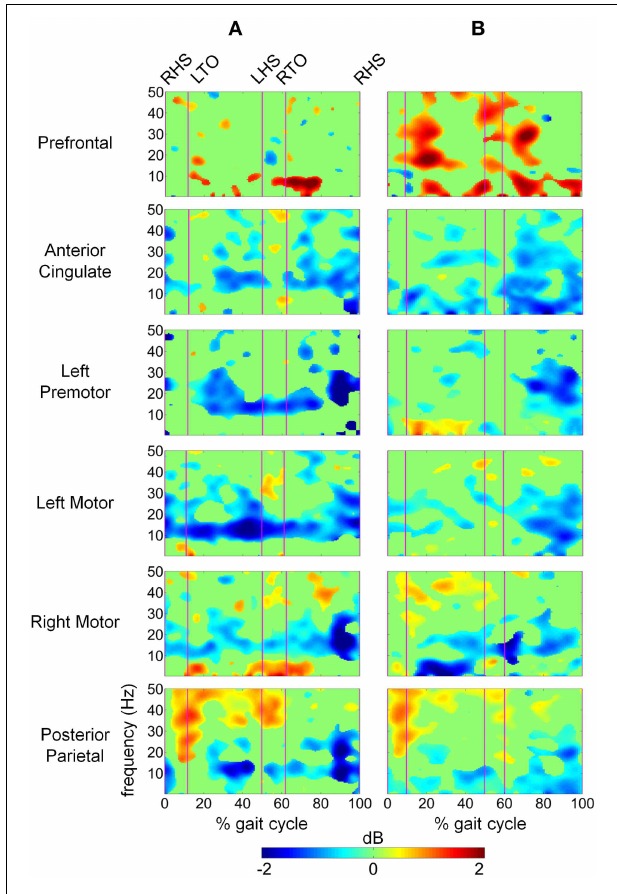
FIGURE 6 | Time-frequency spectrograms showing the power differences between active and passive walking for (A) slow speed and (B) fast speed in dB. Spectrograms are masked for significance ( α < 0.05) with non-significant differences set to 0dB